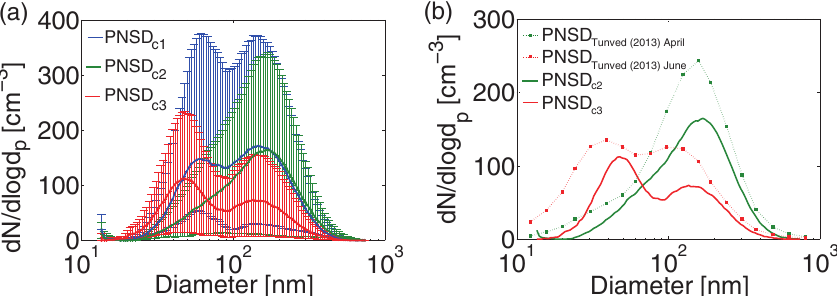
Figure 8. (a) Thick lines show the median PNSD of Period 1 (blue), Period 2 (green) and Period 3 (red). The thin vertical lines (same colour code) indicate the range between the 25 and 75% percentiles. (b) Comparison of the median PNSD of periods 2 and 3 with 10-year median PNSD of April and June observed by Tunved et al. (2013) on Svalbard. The PNSDs observed by Tunved et al. (2013) for April and June are comparable in shape with PNSD c2 and PNSD c3 ,